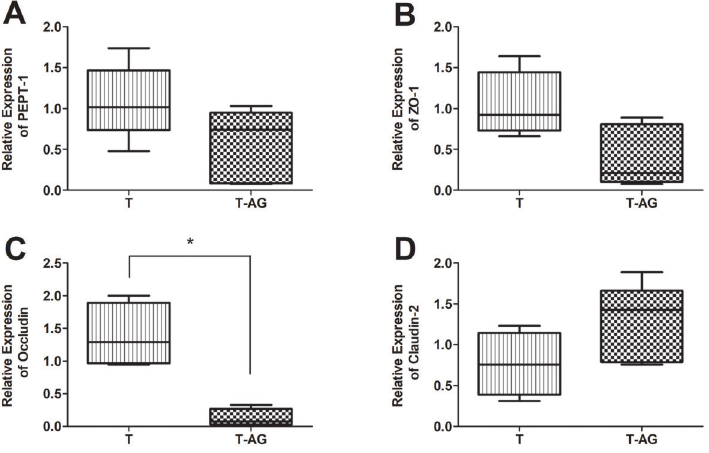
Figure 4. Relative mRNA expression of ( A ) peptide transporter-1 (PEPT-1), ( B ) zonula occludens-1 (ZO-1), ( C ) occludin, and ( D ) claudin-2 between trained animals without supplementation (T group) and trained animals supplemented with alanyl-glutamine (T-AG). The data are reported as median, minimum and maximum, and interquartile range (n=8). *P o 0.05 compared with the T group (Mann-Whitney